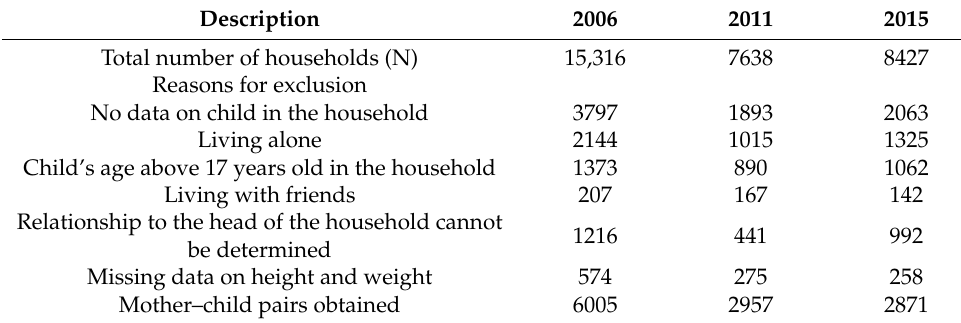
Table A1. Exclusion criteria of the households.